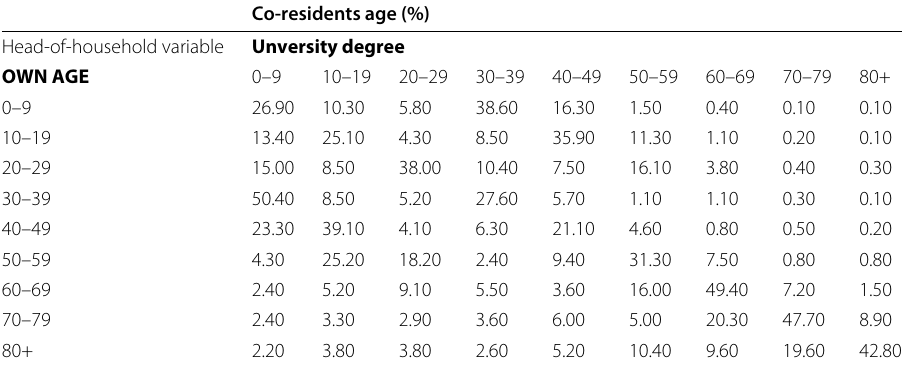
Table 8 Share of co-residents members by age and head-of-household education level ( Continued )